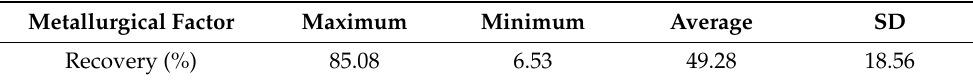
Table 2. The statistical measures of sulfur recovery (the output variable).